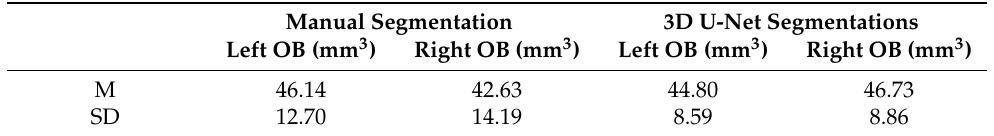
Table 4. OB volumes of manual segmentations and predicted segmentations of the algorithm for the test dataset.